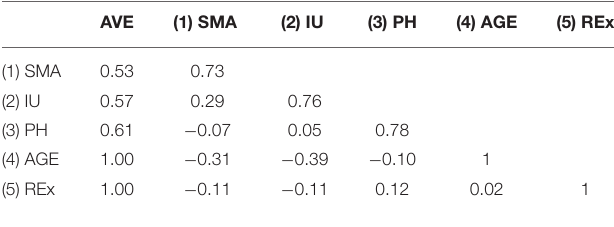
TABLE 5 | Construct discriminate analysis.